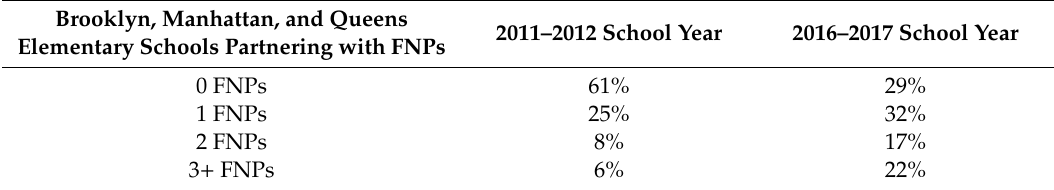
Table 7. Comparison of 2011–2012 and 2016–2017 FNP Data for Elementary Schools in Three Boroughs. Brooklyn, Manhattan, and